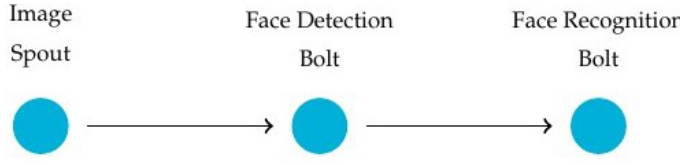
Figure 7. Storm application topology used in